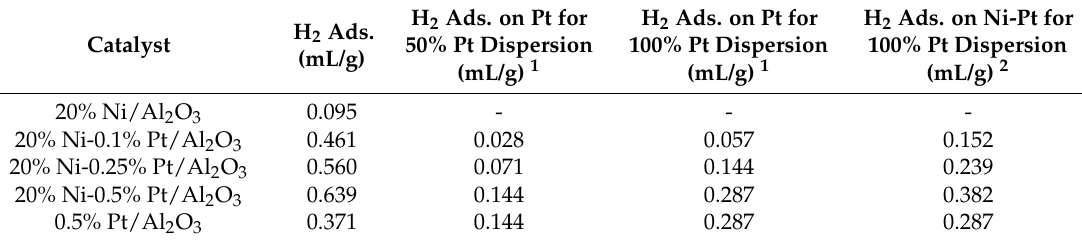
Table 2. Pulsed H 2 chemisorption results of the catalysts